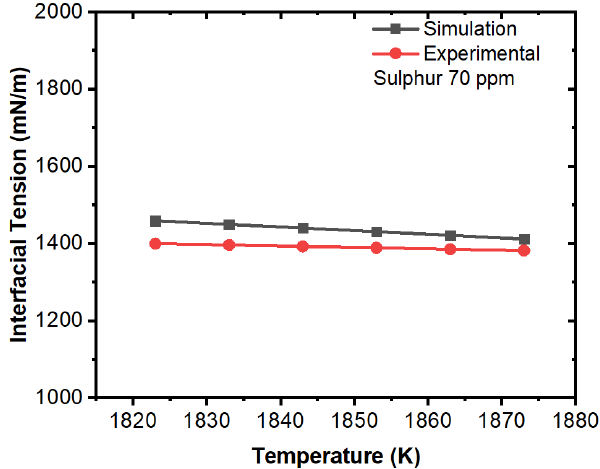
Figure 16. Comparison of experimental and simulation results of interfacial tension with respect to temperature (sulfur: 40 ppm, experimental work by Jeong et al. [26]).